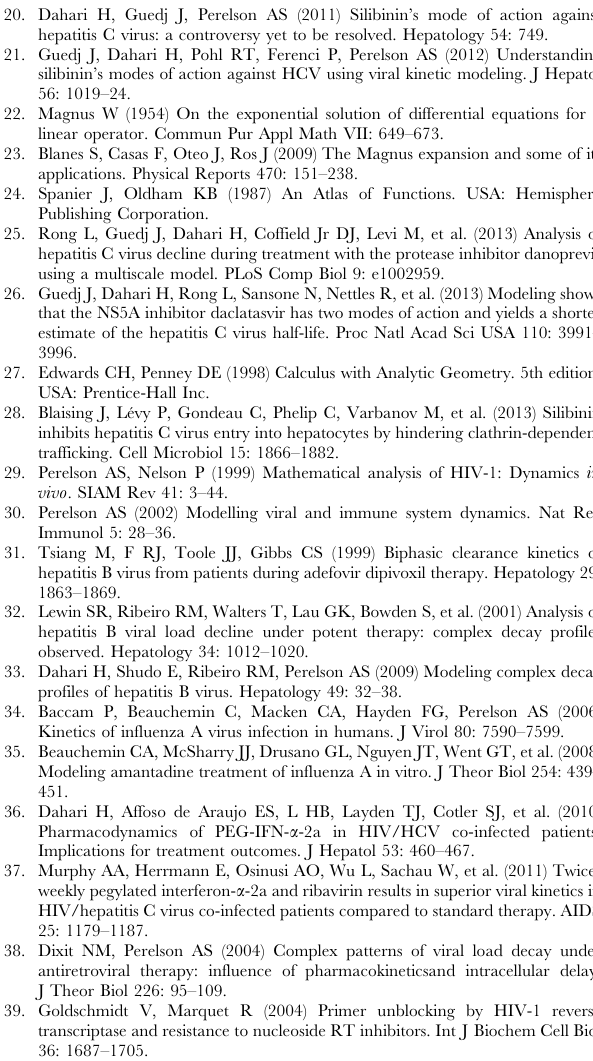
Table S1 Modified Bessel function order n for the different treatment regimens in Table 1. n is the order of the modified Bessel functions I n ( x ) and K n ( x ) in the solution (11). The approximation to the analytic solution that we use depends on whether n v 1 or n w 1 (cf.